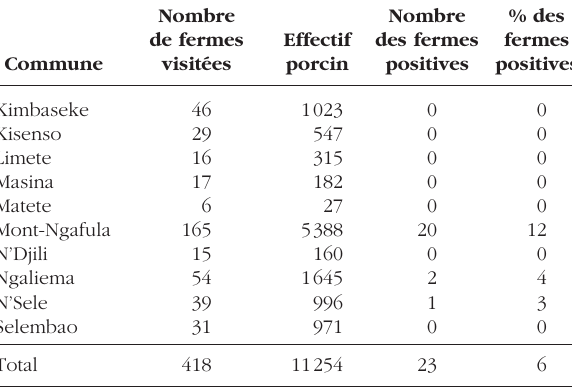
Tableau I. – Résultats des tests parasitologiques réalisés dans les fer- mes des différentes communes.